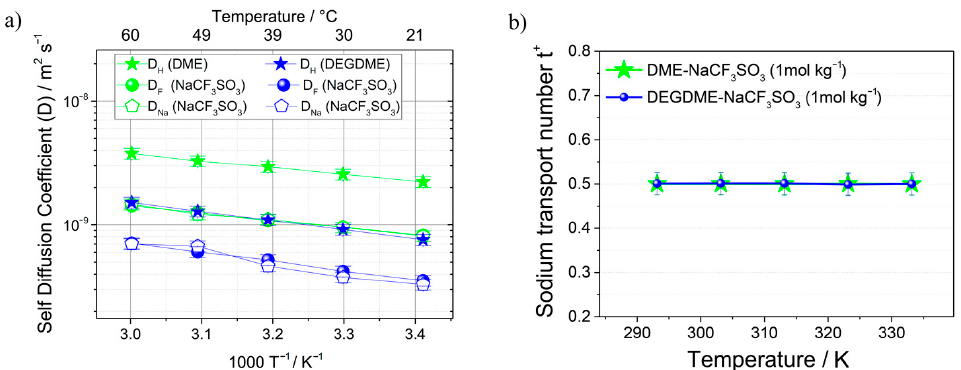
Figure 34. ( a ) Self-diffusion coefficients of 1 H, 19 F and 23 Na in the DME-NaCF 3 SO 3 (1 mol/kg) and DEGDME-NaCF 3 SO 3 (1 mol/kg) electrolytes determined from 20 °C to 60 °C by PFG-NMR. ( b ) Sodium transport number ( t + ) calculated from the self-diffusion coefficients measured by PFG-NMR [135].